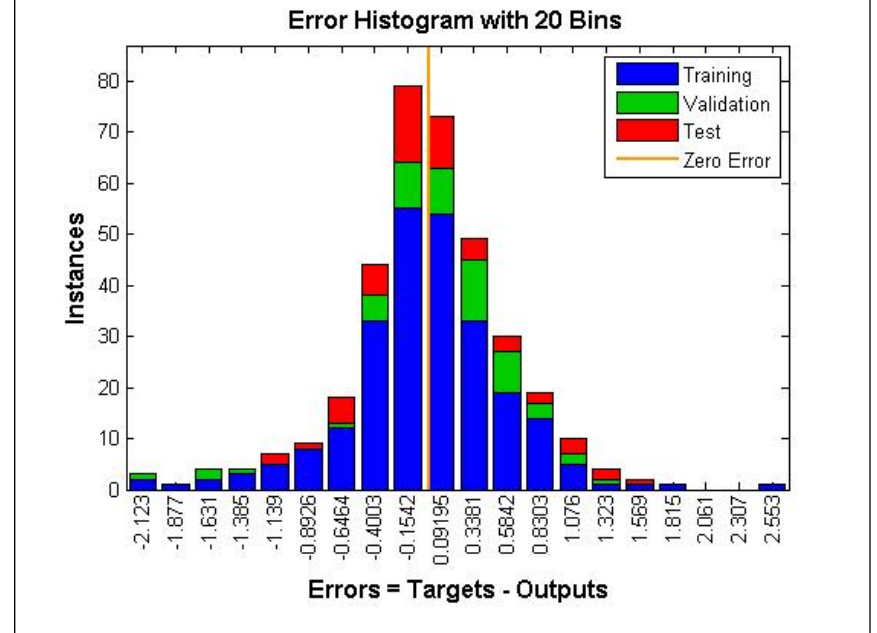
Figure 13. Error histogram for SWSI input model number 3.